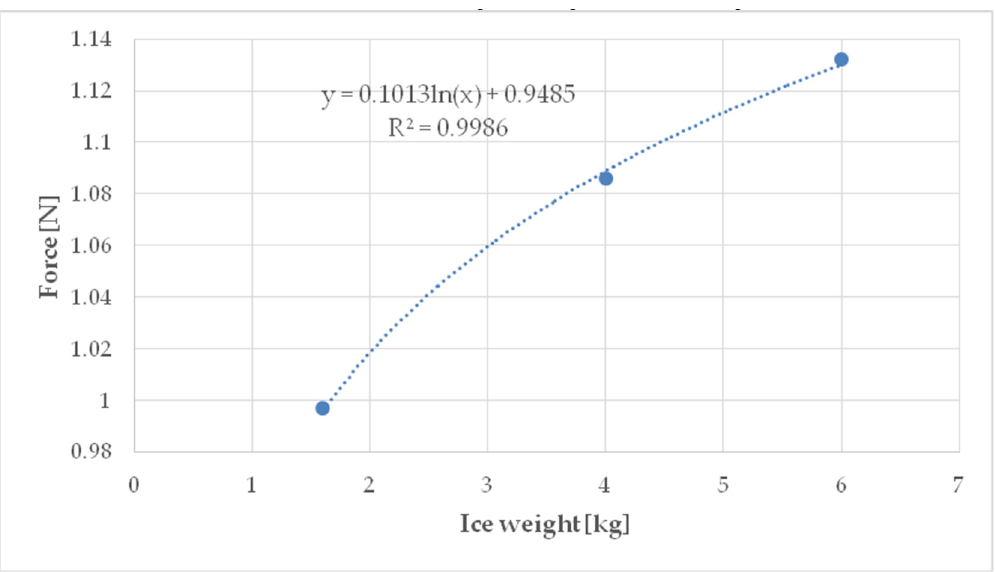
Figure 8. Correlation between the average drag force and the mass of introduced ice.